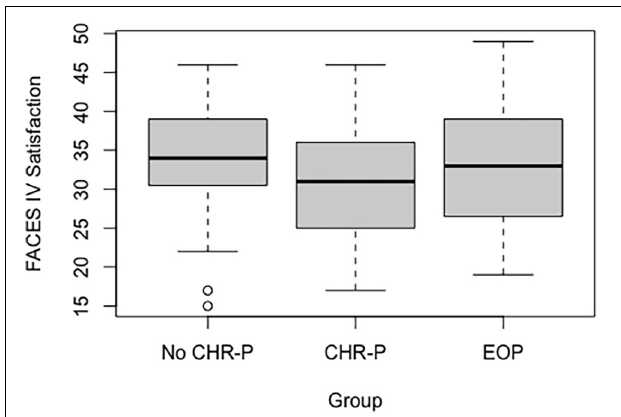
FIGURE 3 | Fathers’ satisfaction subscale in the three subgroups.